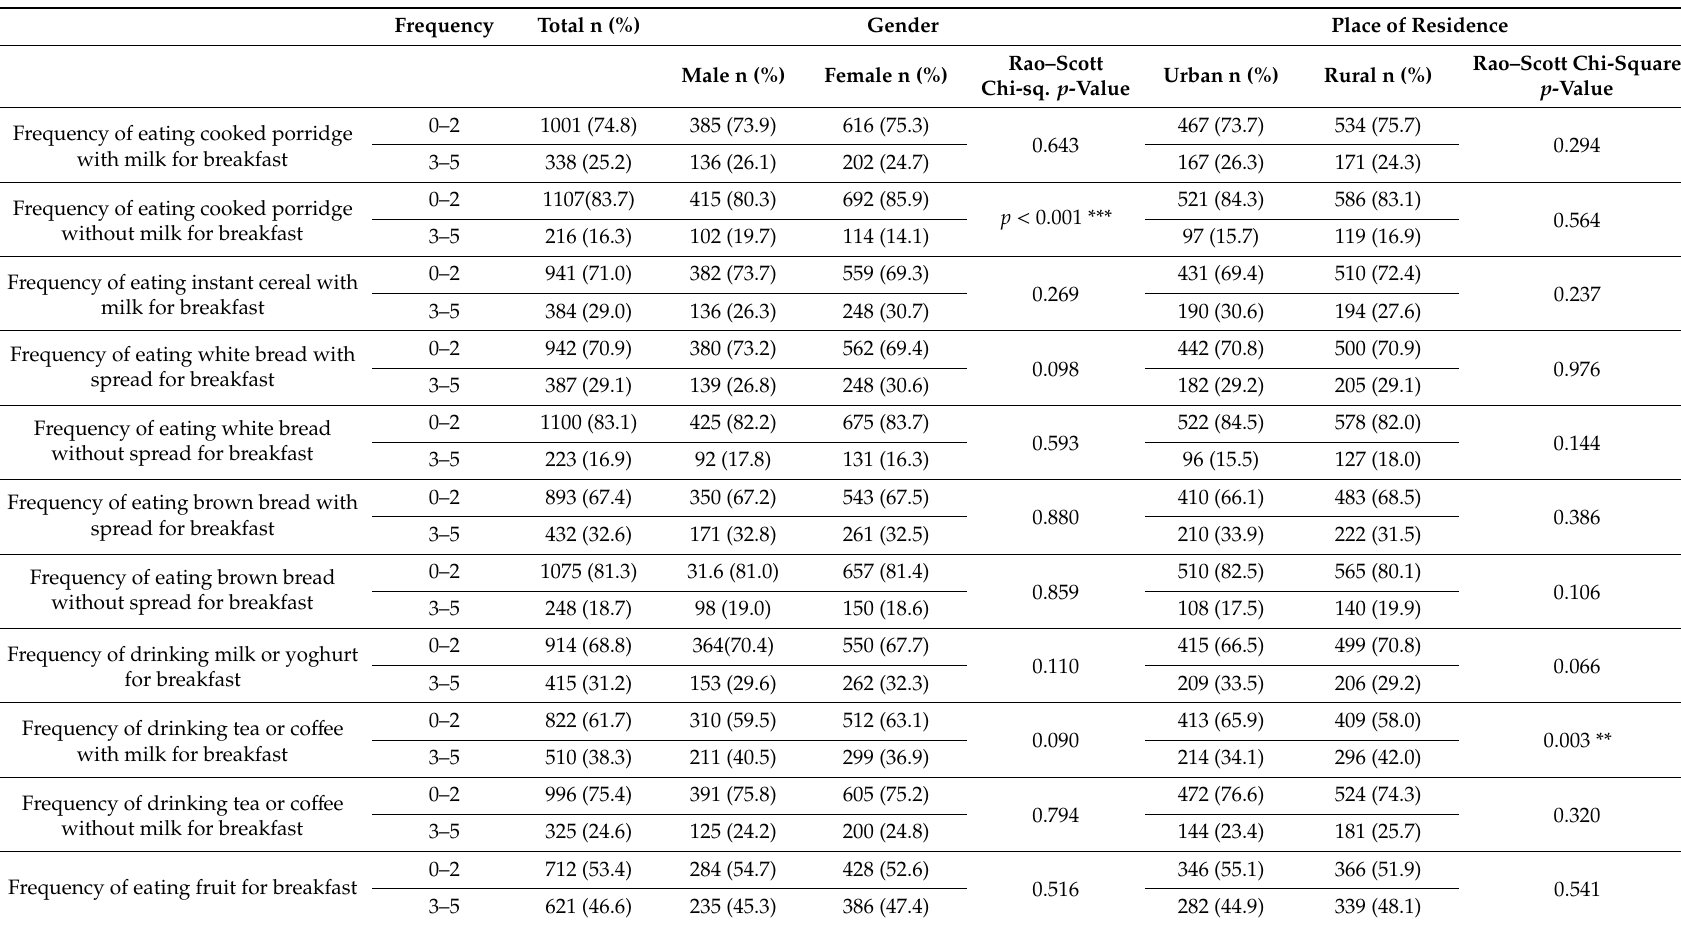
Table 4. Usual breakfast consumption patterns during school days for learners in secondary schools in the Eastern Cape (N =